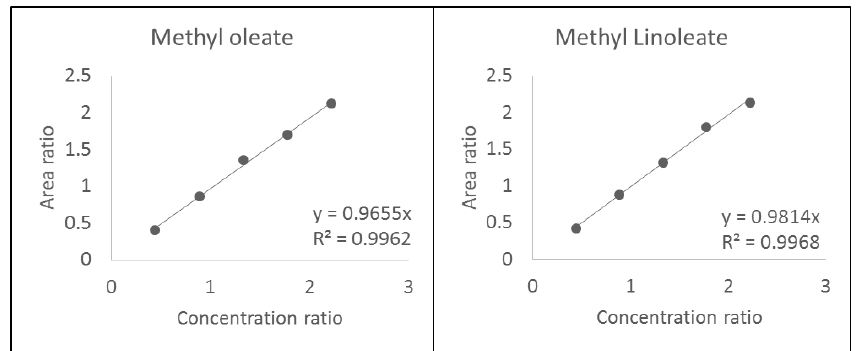
Figure A1. Calibration curves of methyl-oleate and methyl-linoleate.